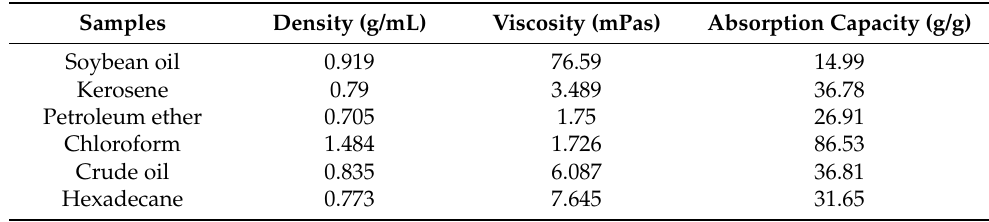
polyurethane (PU) sponges for various organic oils and solvents (20 ◦